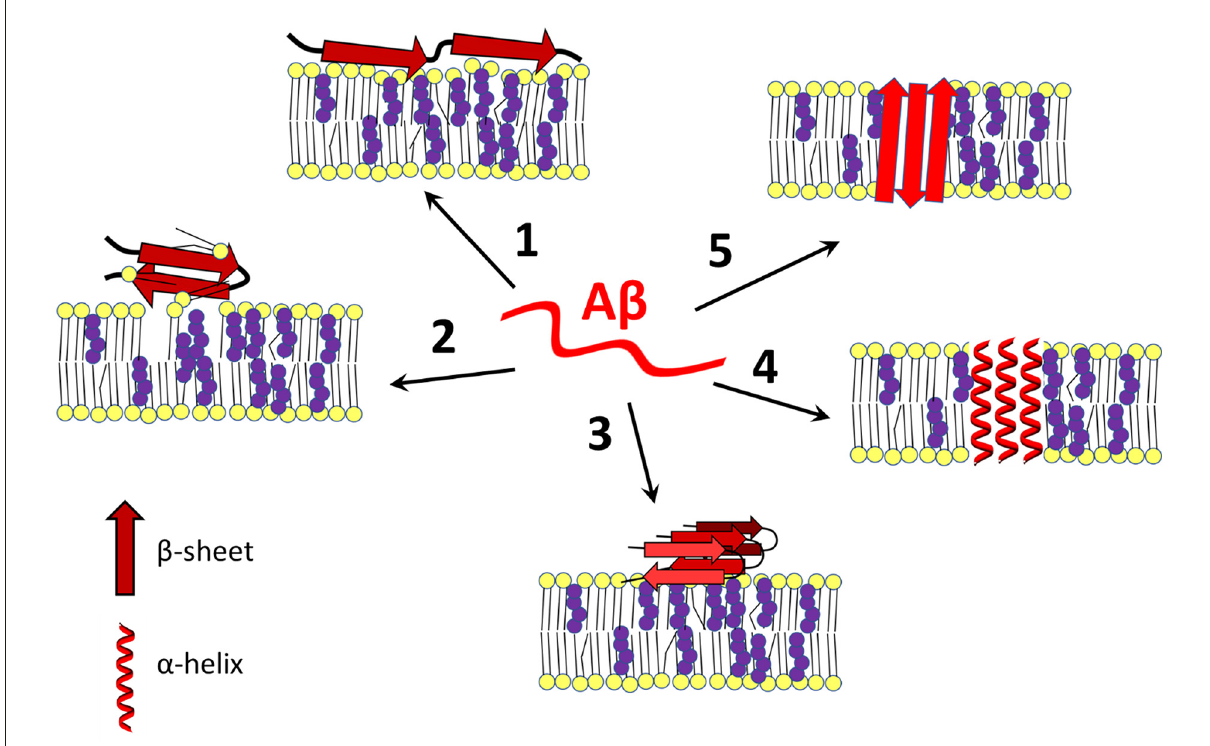
FIGURE1 Amyloid β -membrane interactions. Amyloid β interacts with the plasma membrane in different ways, leading to disruption of cell homeostasis. A β exists in a disordered state (in the center) or can change its conformation to an α -helical or β -sheet containing form after contact with membrane lipids (especially cholesterol-richlipid rafts), A β binds tothe surface of thebilayer and destabilizes themembrane by a carpetingeffect (1), or itmay act as a detergent (2). In addition, the membrane may serve as a platform for aggregation of A β in its most harmful β -sheet-rich conformation (3). Under certain conditions, with or without the help of cholesterol, A β self-organizes into an α -helical (4) or β -barrel (5) transmembrane pore that is often selective for calcium ions. Changing cholesterol content and leaflet distribution may cause A β to transition from the surface-bound to the transmembrane form and vice-versa (not shown). Red—amyloid β , yellow—membrane lipids, purple—cholesterol. The scheme was prepared according to Eckert et al. (2001), Yip et al. (2002), D’Errico et al. (2008), Abramov et al. (2011), Zhao et al. (2011), Drolle et al. (2012), Yu and Zheng (2012), Fantini et al. (2014), Seghezza et al. (2014), Brown and Bevan (2016), Press-Sandler and Miller (2018), Staneva et al. (2018), Fabiani and Antollini (2019), Qu et al. (2019), and Banerjee et al.